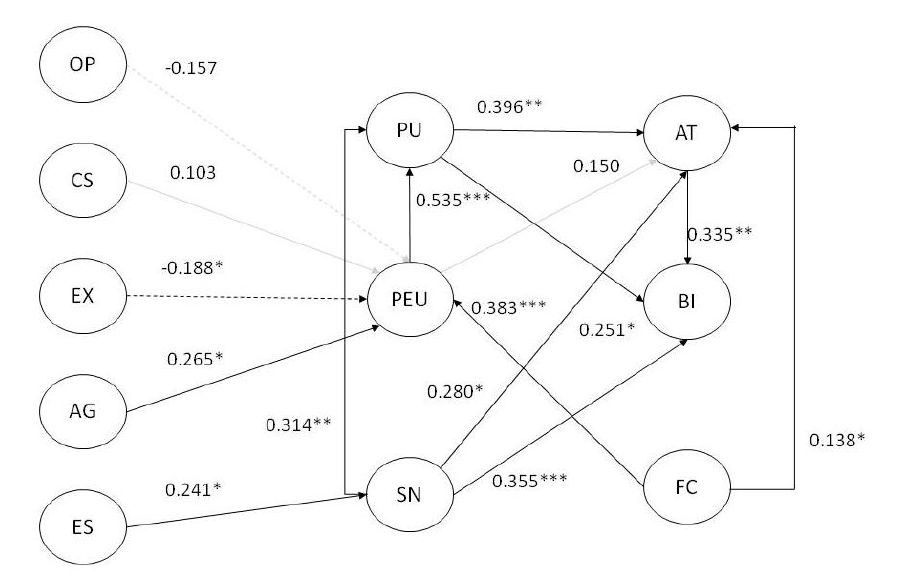
Figure 3. Structural Model (post-wiki